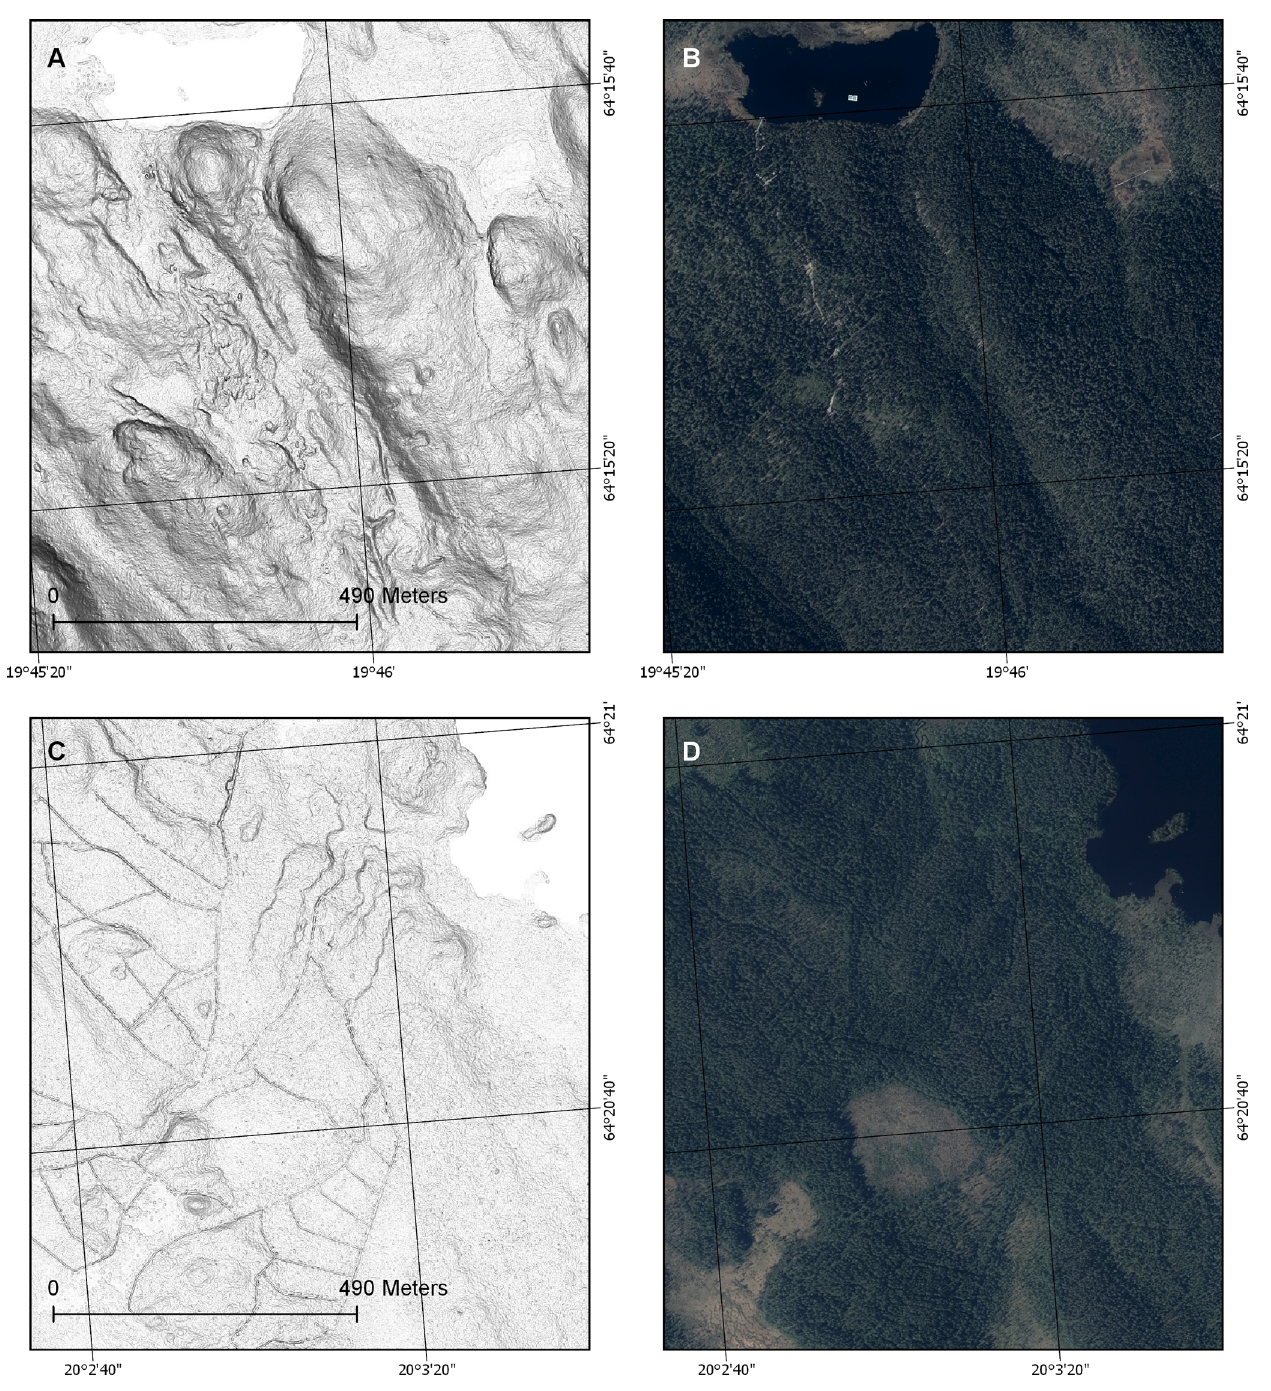
Figure A1. Hillshade and aerial photo of the two mapped areas shown in Fig. 5. © Lantmäteriet.